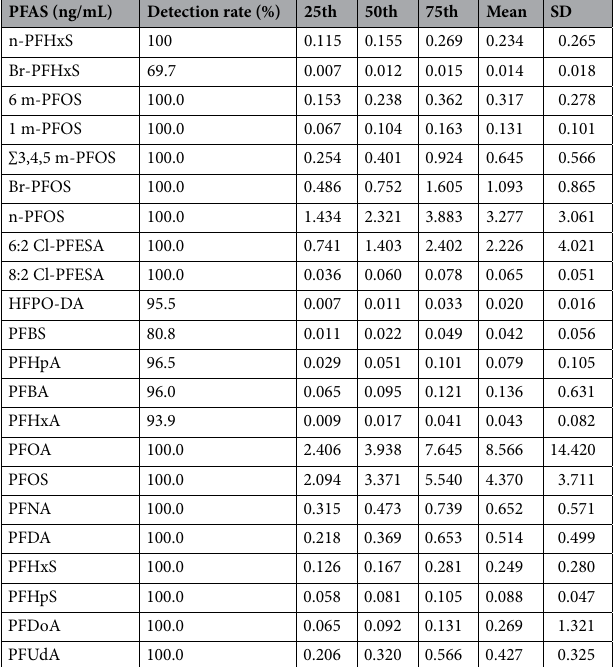
Table 2. Distribution of plasma PFAS.